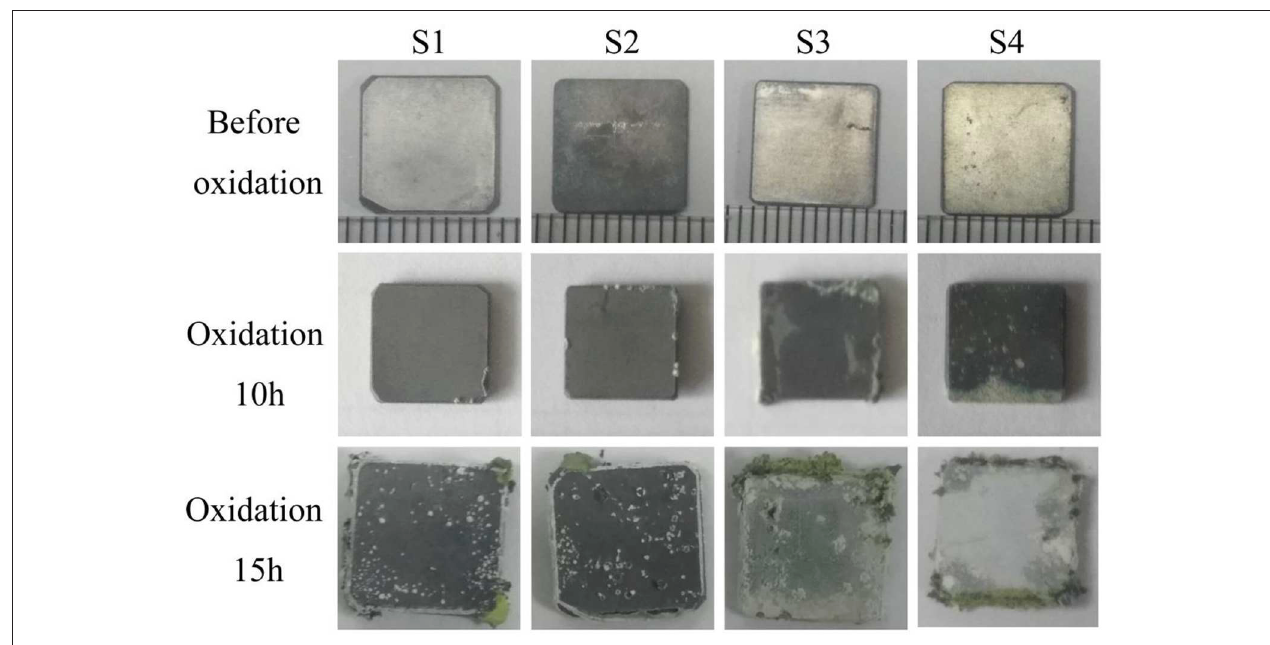
FIGURE 7 | Surface images of coated samples after 0, 10, and 15h of oxidation at T = 1,000 ◦ C.